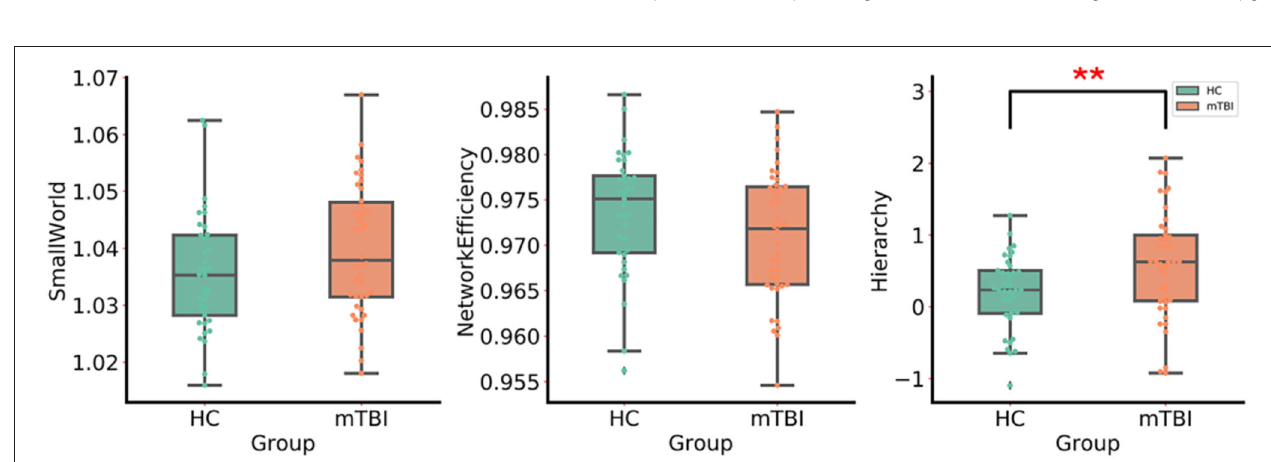
FIGURE 2 | The group differences in the global network metrics of WM structural networks. ** Indicates p < 0.05. mTBI, mild traumatic brain injury; HC, healthy control.